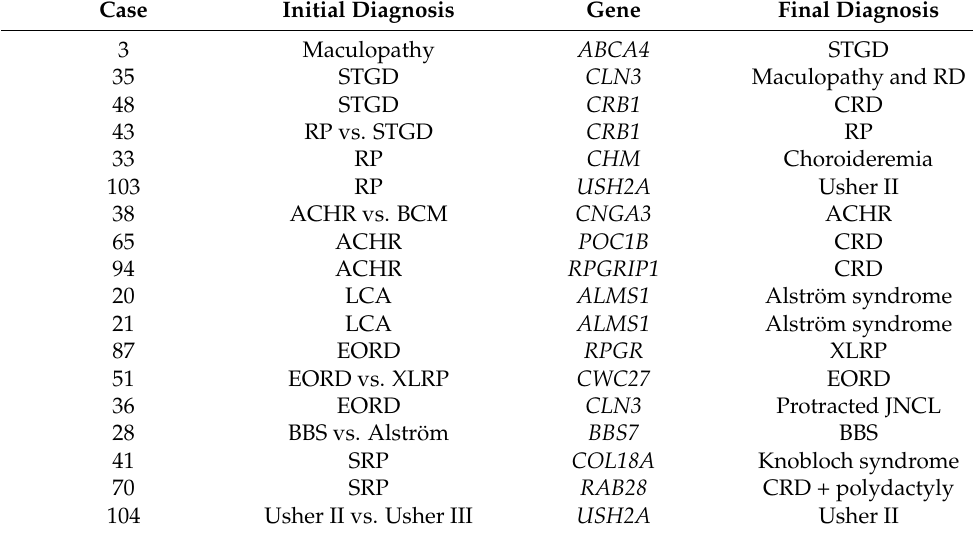
Table 3. Reclassified